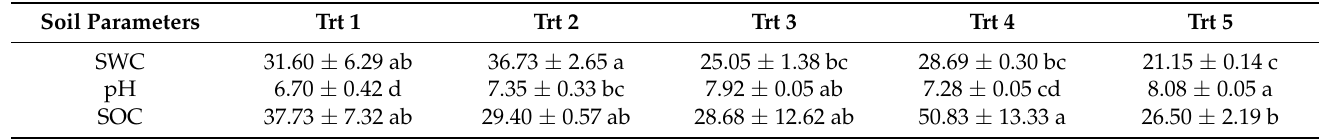
Table 2. Soil parameters in different planting